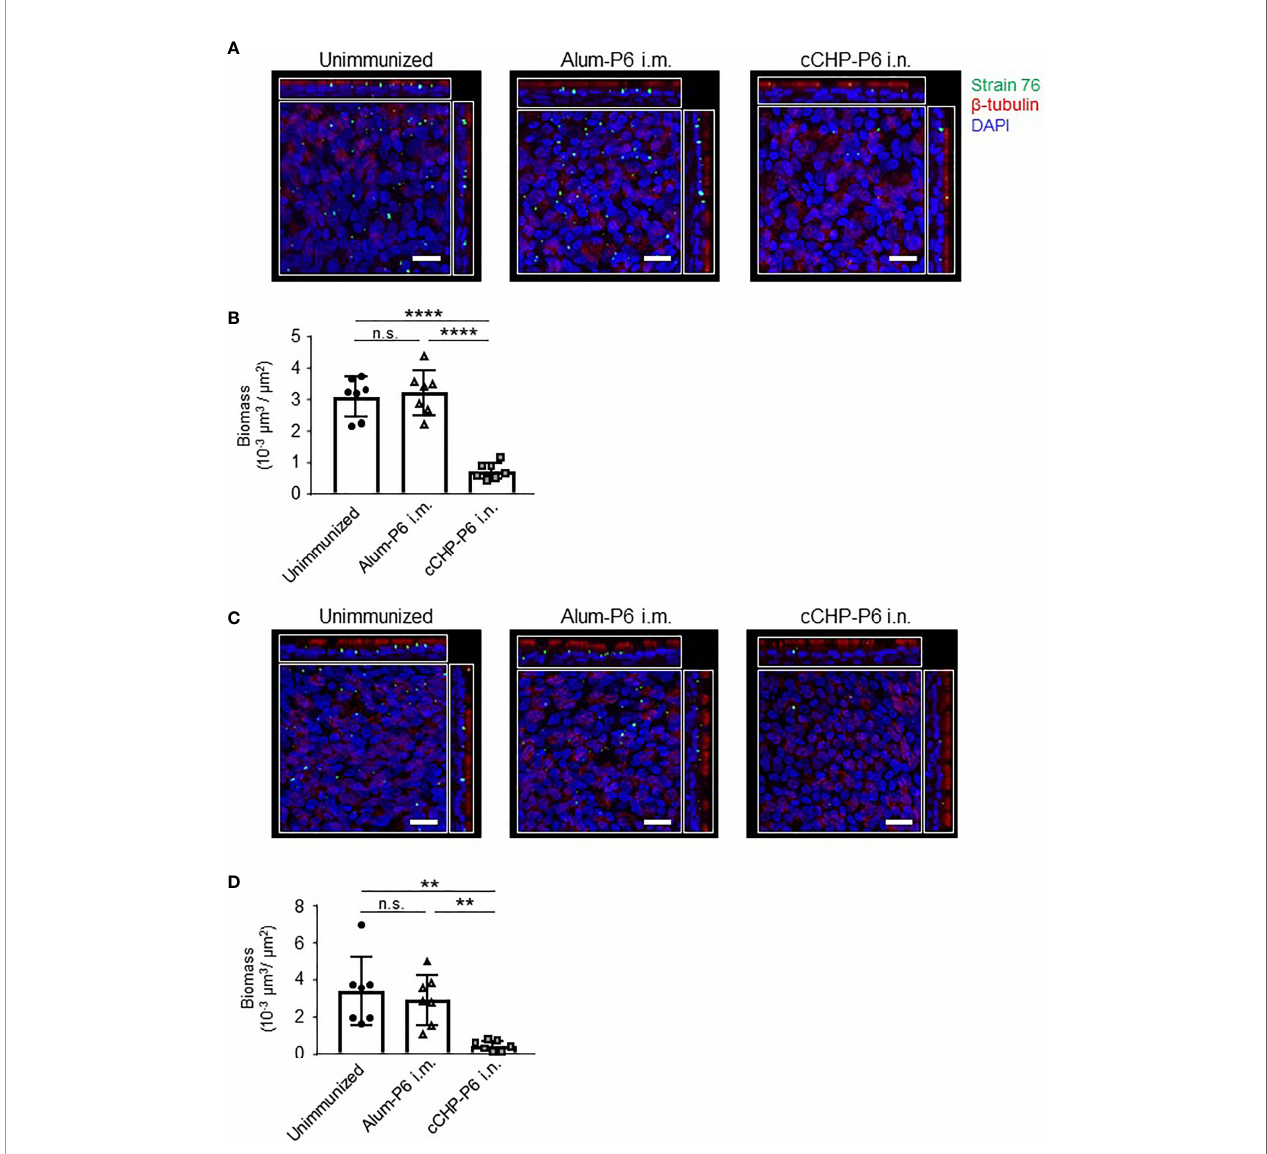
FIGURE 5 | P6-speci fi c IgA prevents the attachment of NTHi to human nasal epithelial cells. (A – D) A bacterial adherence assay was performed by using FITC- labeled NTHi strain 76. NTHi were pretreated with nasal washes (A) or IgG-depleted nasal washes (C) from immunized mice and then incubated with 3D human airway epithelium cultures at 37°C, 5% CO 2 for 6 h. Epithelial cells were stained with b -tubulin (red) to visualize the cilia and with DAPI (4 ′ ,6-diamidino-2-phenylindole; blue) to visualize the nuclei. Images were obtained by confocal laser scanning microscopy. The number of NTHi organisms on the epithelial cells was determined according to the FITC signals in randomly selected fi elds of an image of the slide, and biomass values were quanti fi ed by using COMSTAT2 software (B, D) . Data are representative of three independent experiments. ** P < 0.01; **** P < 0.001; n.s., not signi fi cant. Values are means ± 1